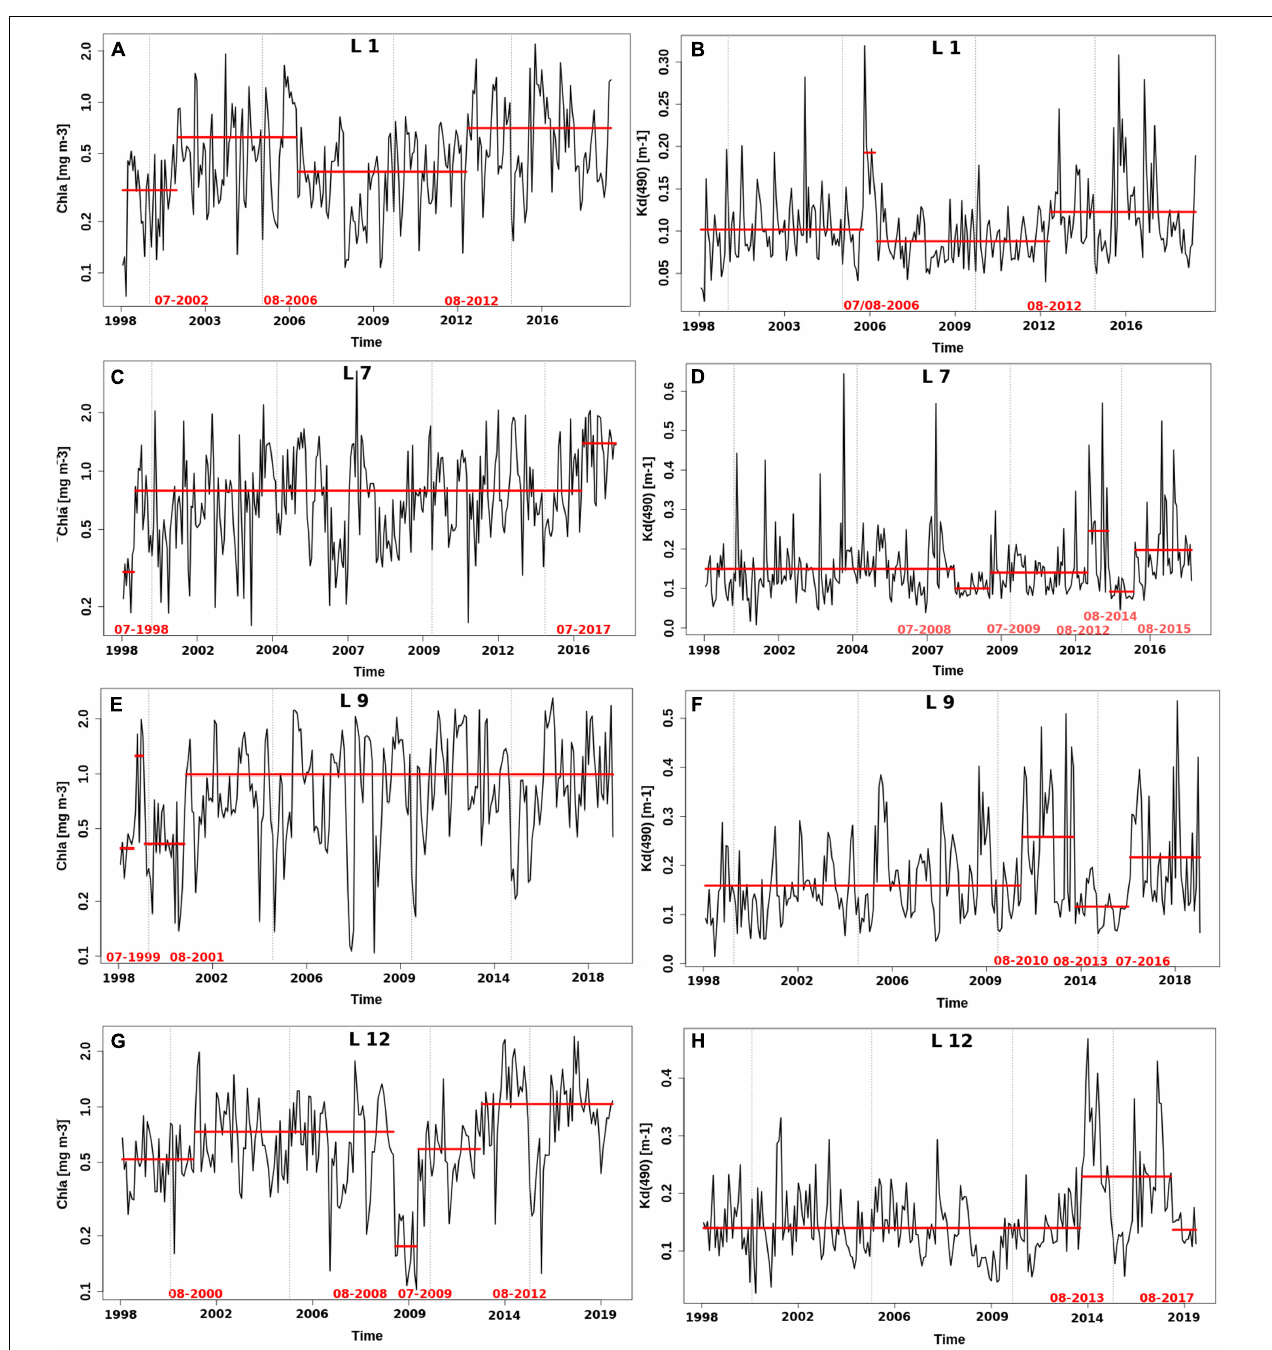
FIGURE 7 | Data series of Chla (A,C,E,G) – left row and K d (490) (B,D,F,H) – right row – stacked values from the summer months at the locations L1 (the shelf near the Kongsfjorden), L7 (the central Isfjorden), L9 (the Bellsund) and L12 (the entrance to the Hornsund fjord) with the segments of consistent water characteristics split at the shift points marked in red line. The turning points were determined based on the PELT changepoint detection method (Killick et al., 2012). Additional vertical gray lines mark the beginnings of the years 2000, 2005, 2010, and 2015.